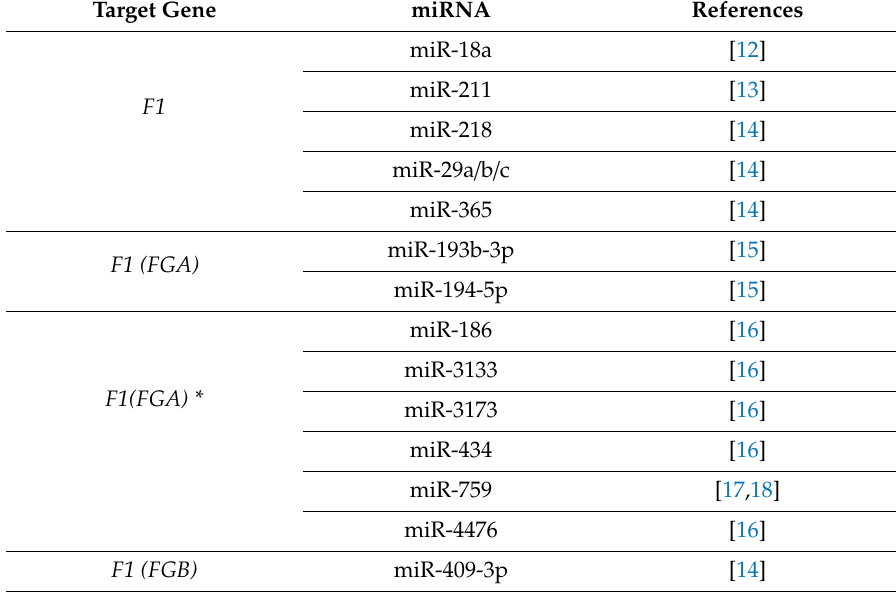
Table 1. MicroRNAs (MiRNAs) that May Target Protein Involved in Coagulation Cascade Which Dysregulation May Lead to Bleeding Disorders or